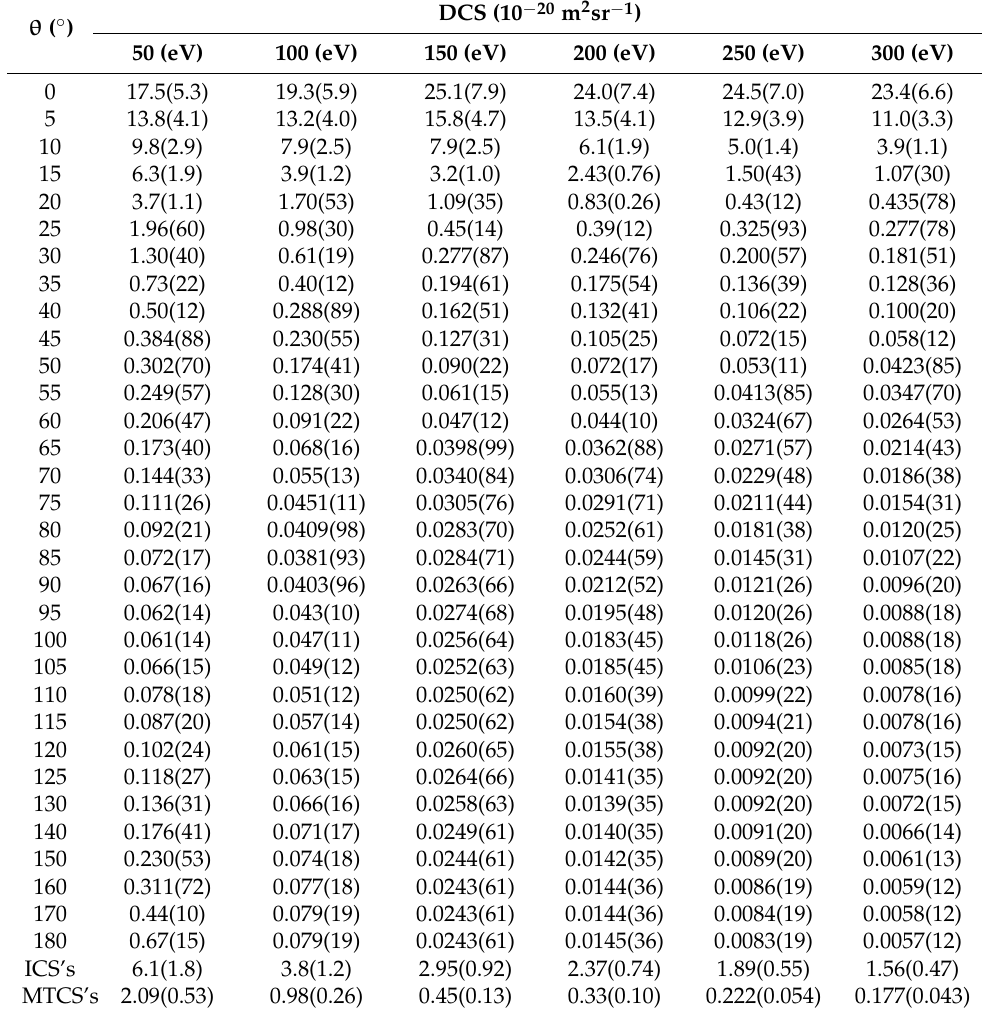
Table 2. Experimental DCSs, integral cross-sections (ICSs), and momentum transfer cross-sections (MTCSs) for elastic scattering of electrons from methane molecule with absolute uncertainties ∆ given in parentheses with 2 last digits. Values from 25 ◦ to 125 ◦ are measured and uncertainties arise from both statistical and short-term stability and include absolute uncertainties of cross-sections for reference Ar gas. Values from 0 ◦ to 20 ◦ and from 125 ◦ to 180 ◦ are extrapolated values and used to calculate ICSs and MTCSs. Uncertainties at small scattering angles are estimated to be